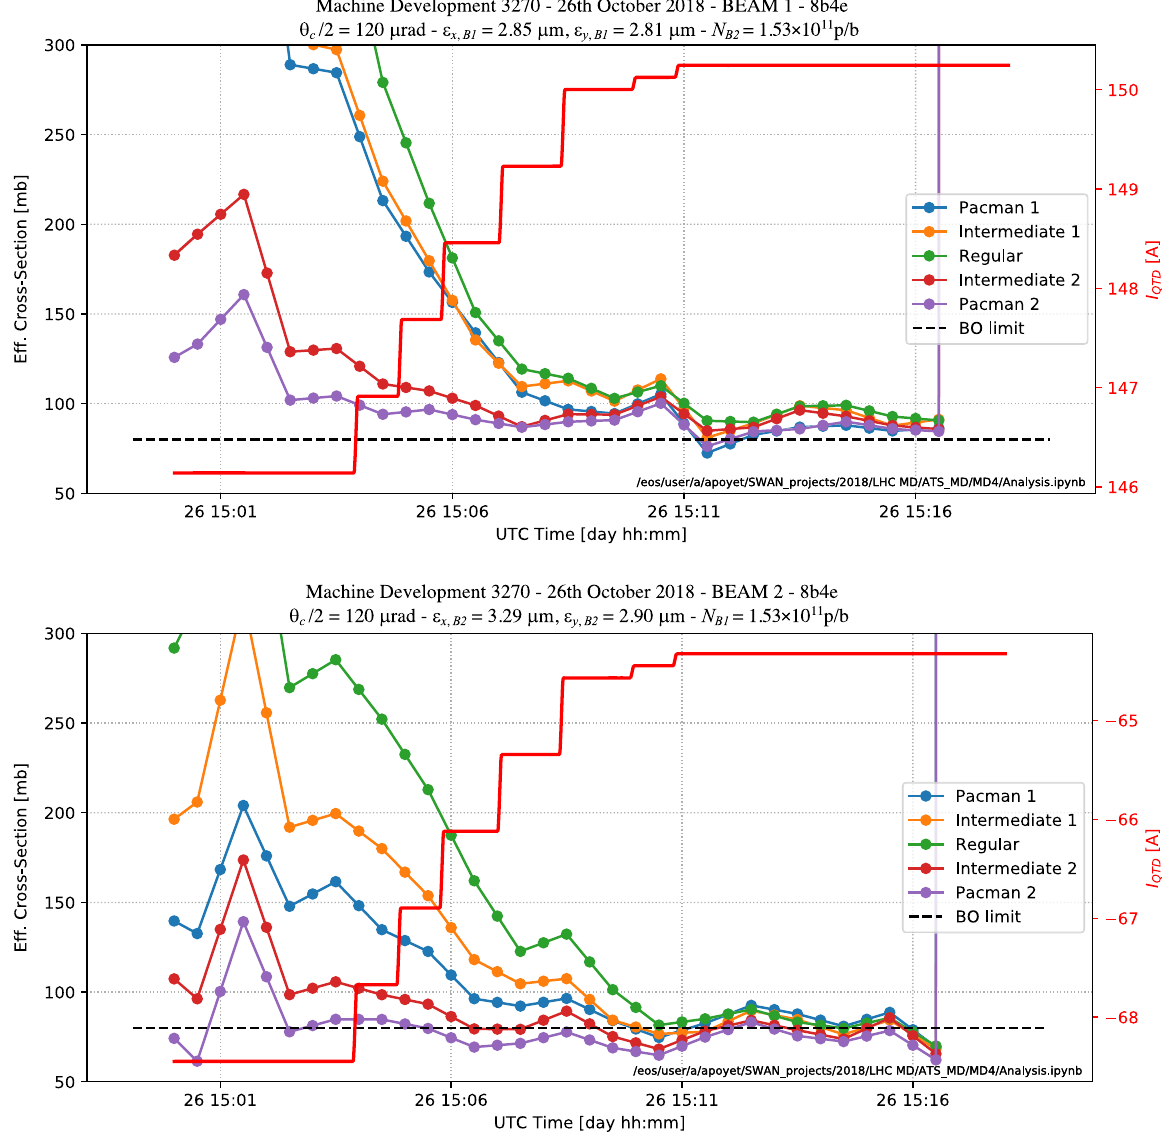
¼ 65 cm ( θ = 2 ¼ 120 μ rad). The burn-off limit was reached for c Tele